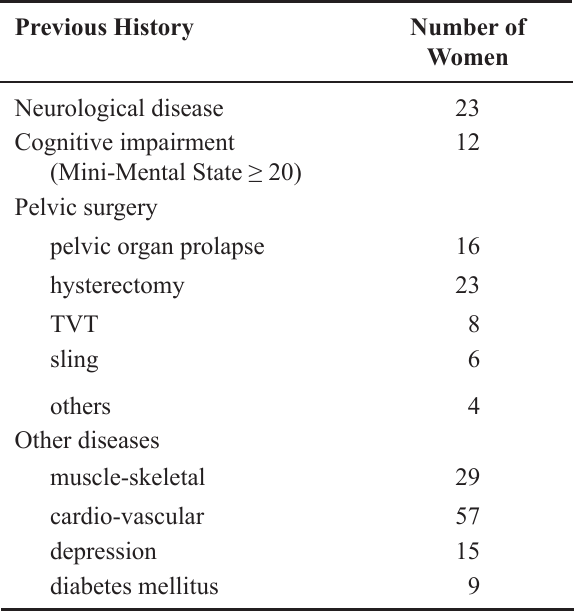
Table 2 – Previous medical history of the studied popula-